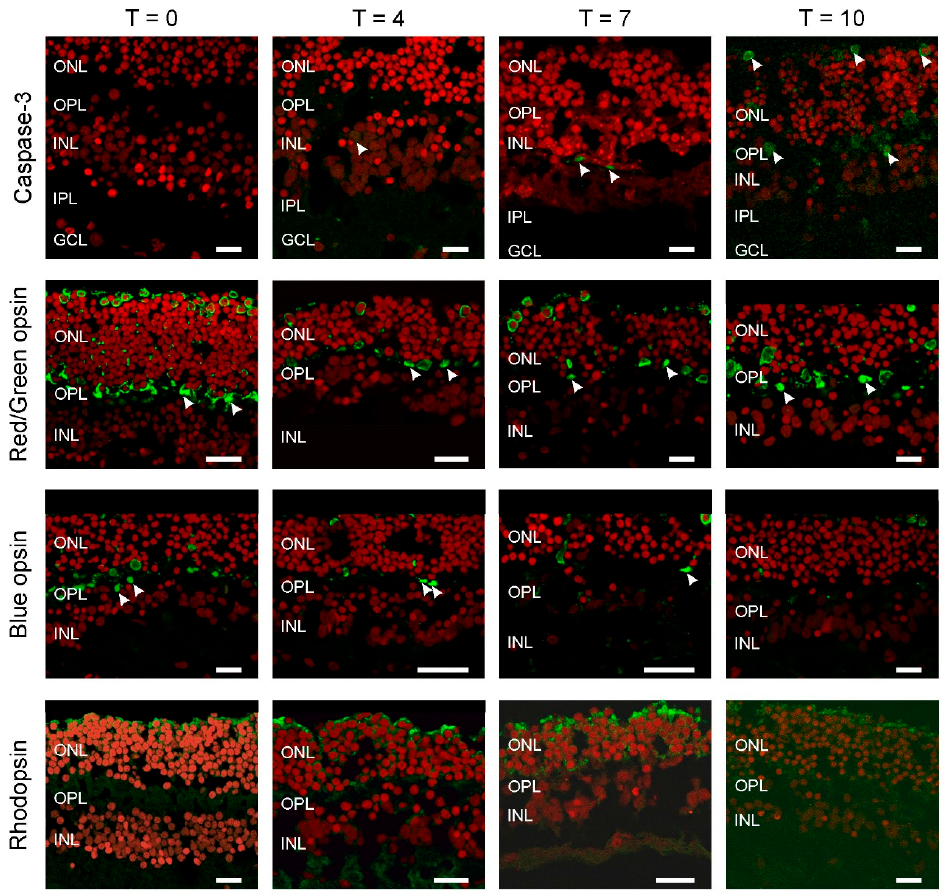
Figure 1. All photoreceptors have lost their outer segments. Apoptosis was studied by Caspase-3 labelling ( top row ). The number of apoptotic cells (arrowheads) remains very limited even after 10 days of culturing (T10). Cone ( middle rows ), rod ( bottom row ) and opsin expression occurred throughout the photoreceptors. Round somata of the photoreceptors are visible at the upper layer of the retina as round structures. An axon connects the somata with the synaptic terminals (arrowheads) in the outer plexiform layer (OPL). The red label is the nuclear stain ethidium bromide. (ONL: outer nuclear layer; INL: inner nuclear layer; IPL: inner plexiform layer; GCL; GC layer. Scale bars indicate 10 µ